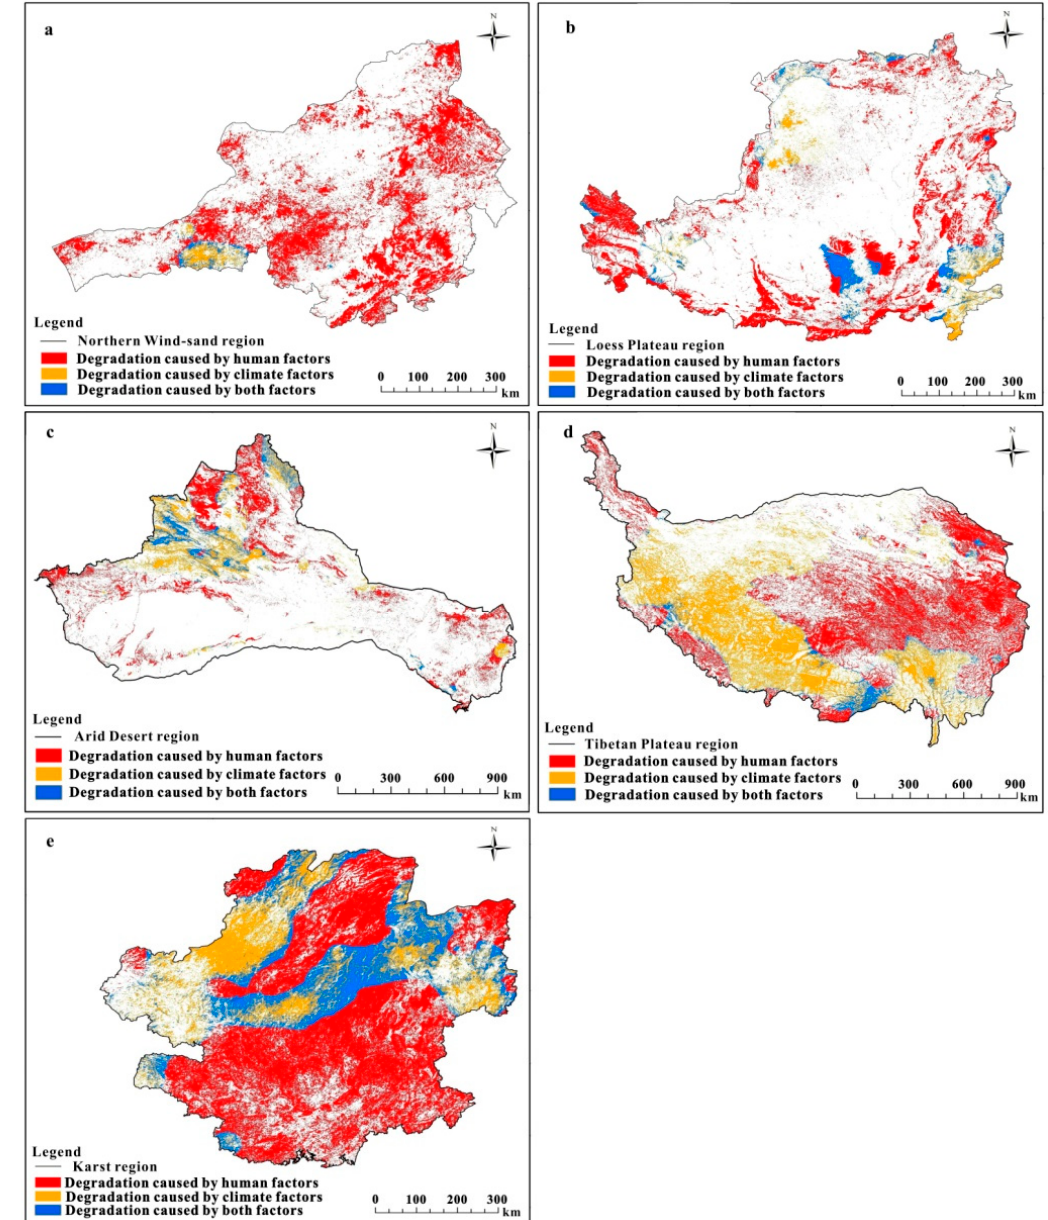
Figure 5. Spatial distribution of vegetation degradation caused by different factors in the Northern Wind-sand region ( a ), Loess Plateau region ( b ), Arid Desert region ( c ), Tibetan Plateau region ( d ), and Karst region ( e ) from 2000 to 2015.